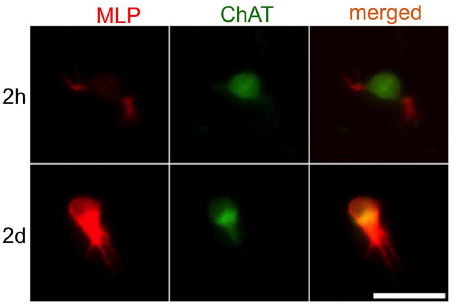
Figure 4. MLP-expression in cultured postnatal AC. Cultured cholinergic AC were obtained from the retina of a P1-rat. The cells were fixed and stained with antibodies against MLP and ChAT after 2 hours and 2 days in culture. After 2 hours, the cholinergic AC showed a week MLP expression in the soma. In sprouting dendrites, however, MLP- expression was more pronounced. After 2 days, the MLP levels dramatically increased in the soma as well as in the dendrites of the cholinergic AC. Scale bar: 25 m